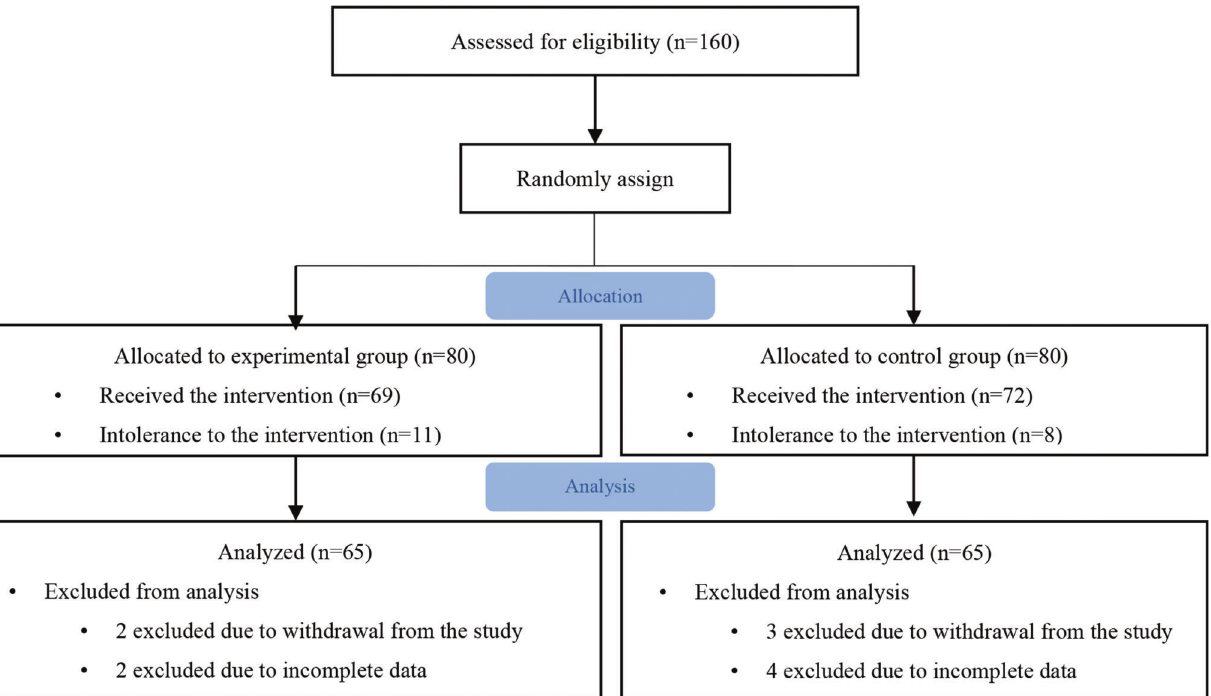
Figure 1 - Flow chart of patient